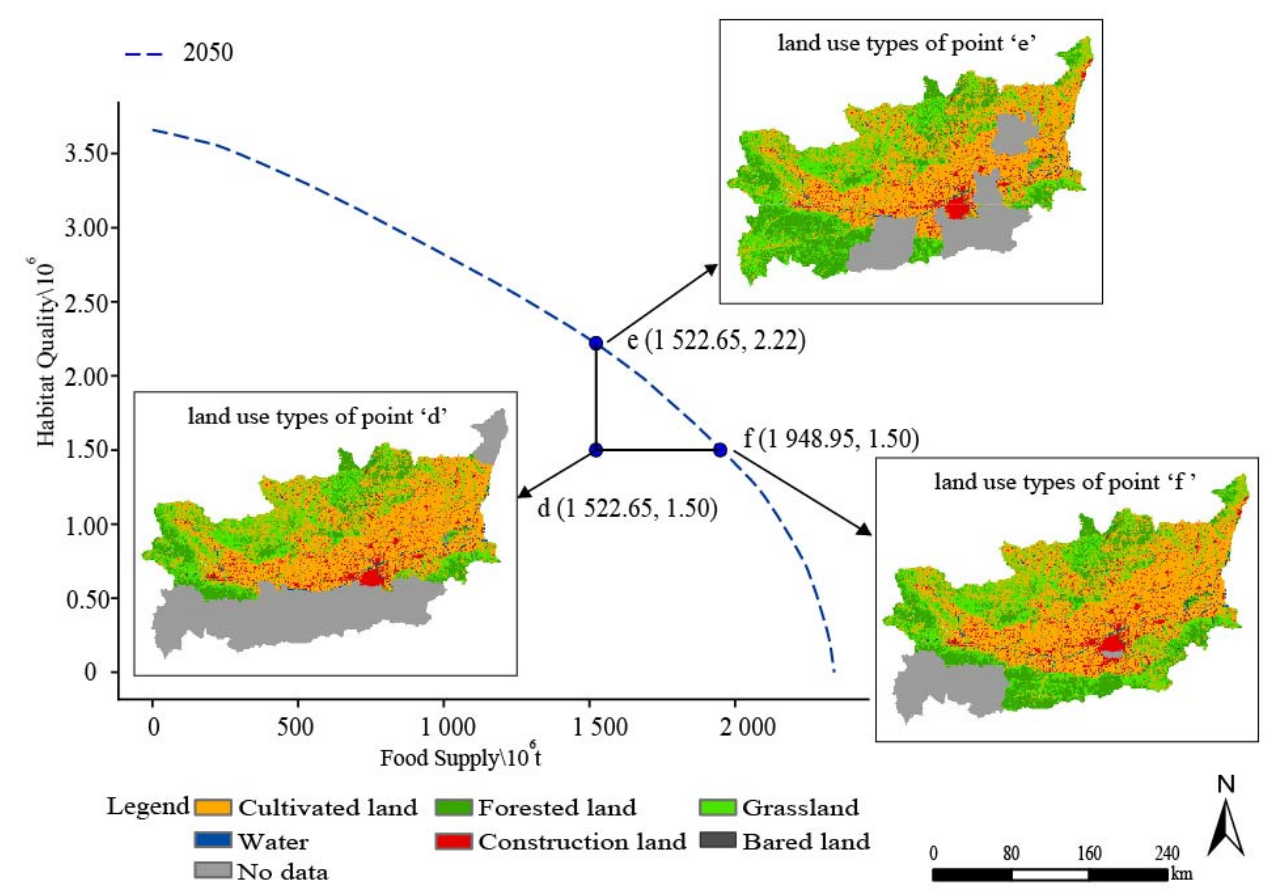
Figure 4. Land use patterns under optimal PPF curves between food supply and habitat quality.